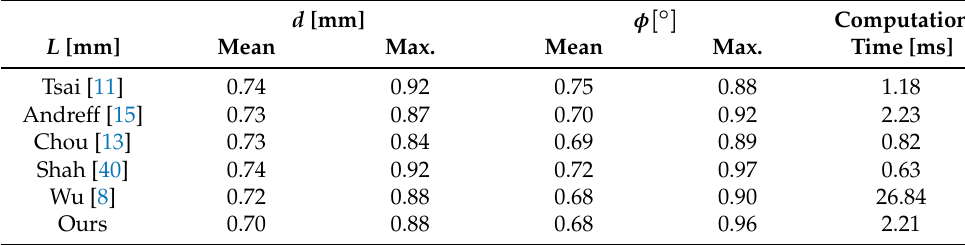
Figure 8. Comparison of our method with the SOTA hand–eye calibration methods. Table 3. Comparison of our method with the SOTA hand–eye calibration